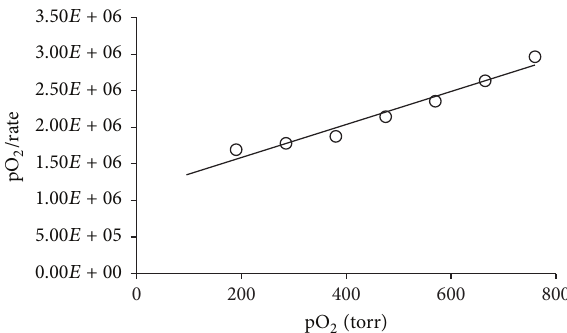
Figure 10: Plot of Langmuir-Hinshelwood noncompetitive model for the oxidation of cyclohexanol to